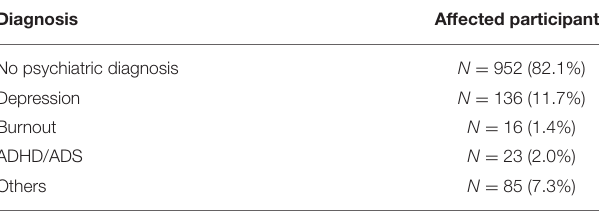
TABLE 4 | Diagnoses of participants’ mental disorders. Diagnosis Affected